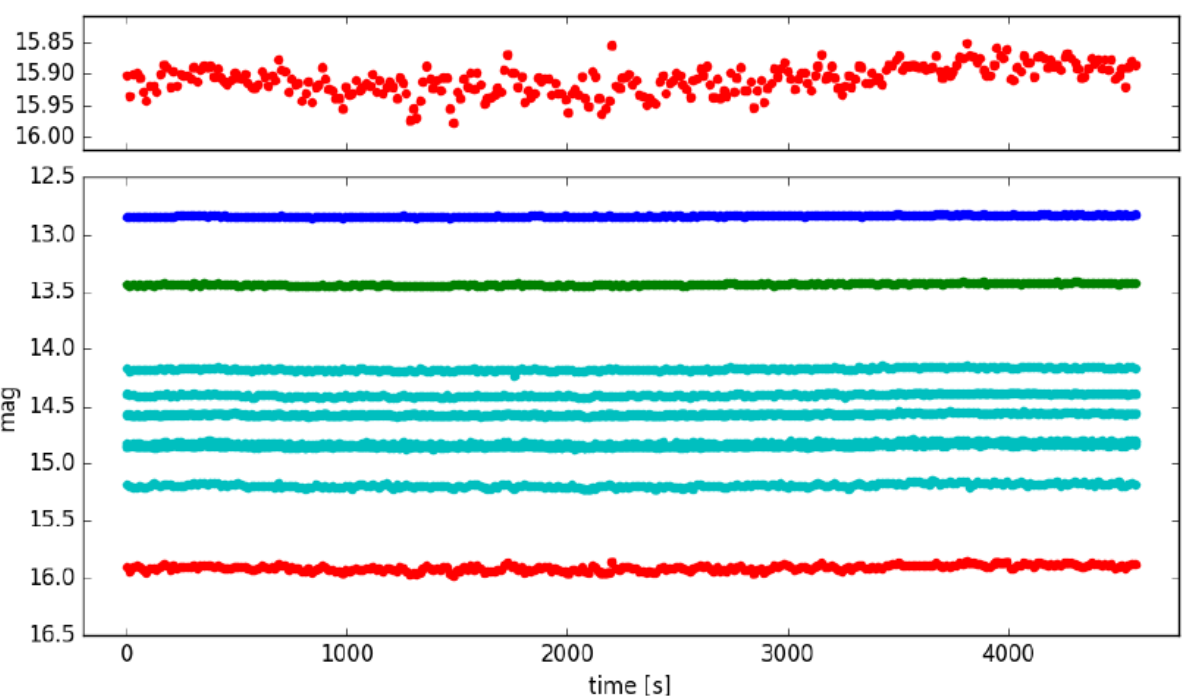
Figure 1. Time series of raw magnitudes of J19384+5824 and of comparison stars in the field of view of the Mercator telescope. The main target is depicted in